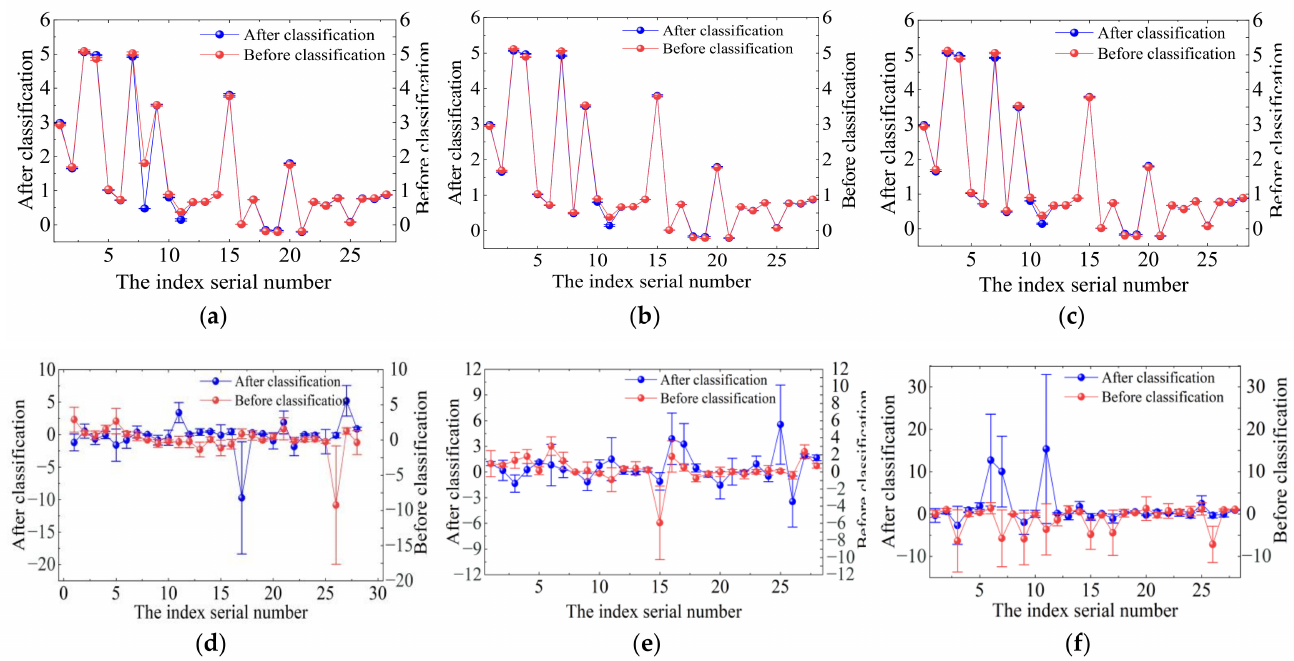
Figure 12. Change trend of some indexes before and after image pixel classification (80 m). Refer to Figure 11 for details of processing ( a – f